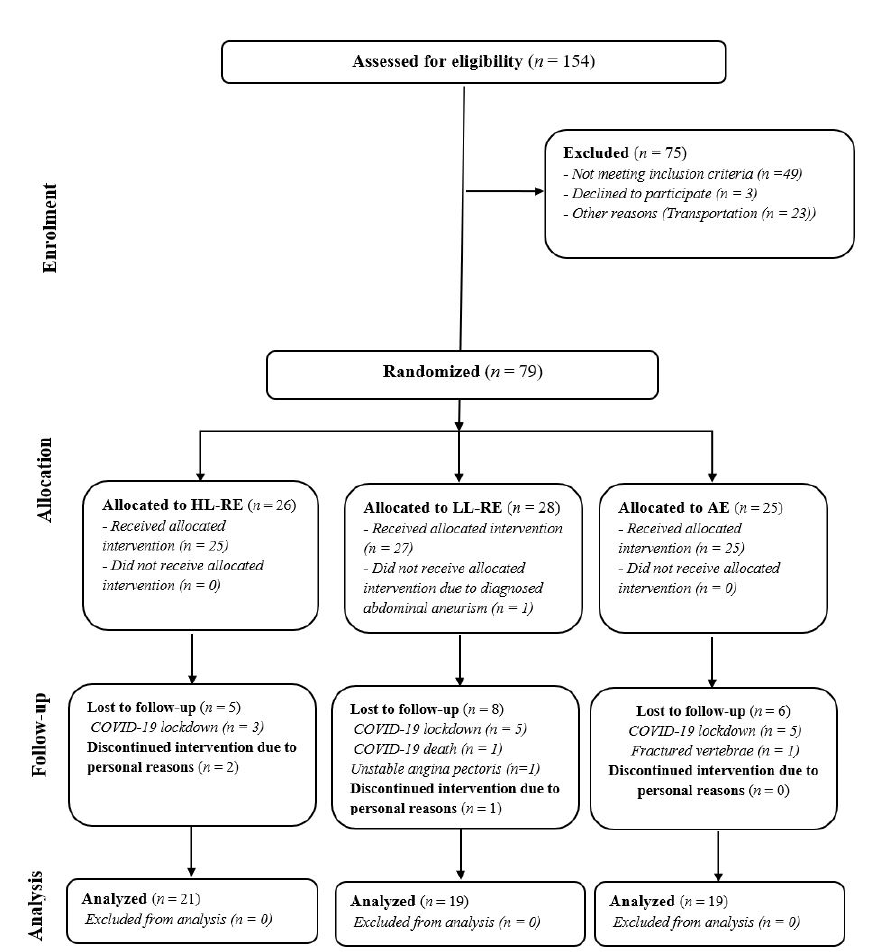
Figure 1. CONSORT study flow. HL-RE: high-load resistance exercise; LL-RE: low-load resistance exercise; AE: aerobic exercise; COVID-19: coronavirus disease-19.